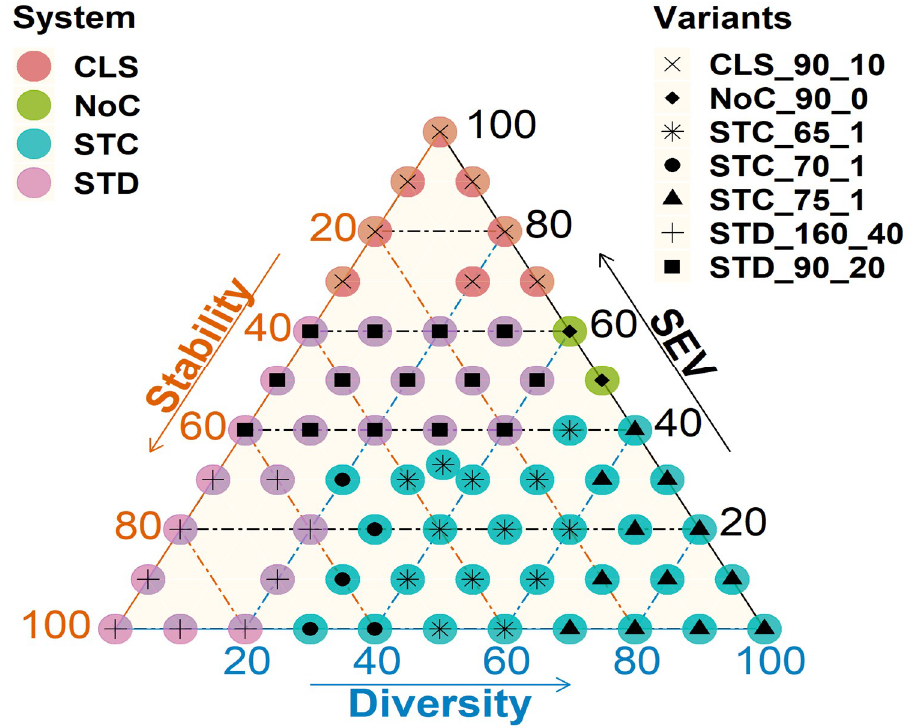
Figure 5. Ternary plot of best harvest‐regeneration variants (see Table 3 for an explanation of abbreviations) with regard to weights of individual criteria. Legend: CLS = large‐scale clearcutting system, NoC = no cutting, STC = selection single tree cutting system, STD = shelterwood based on target diameter. Variants are described in Table 3. Table 3. List of variants with the highest sums of scores that occurred within 63 best variants identified for different combinations of criteria weights by the weighted summation method. Percentage values (% SEV, % Stability, and % H’) were calculated as a ratio of the actual value of the criteria achieved under particular management variant to the maximum value from 450 variants.